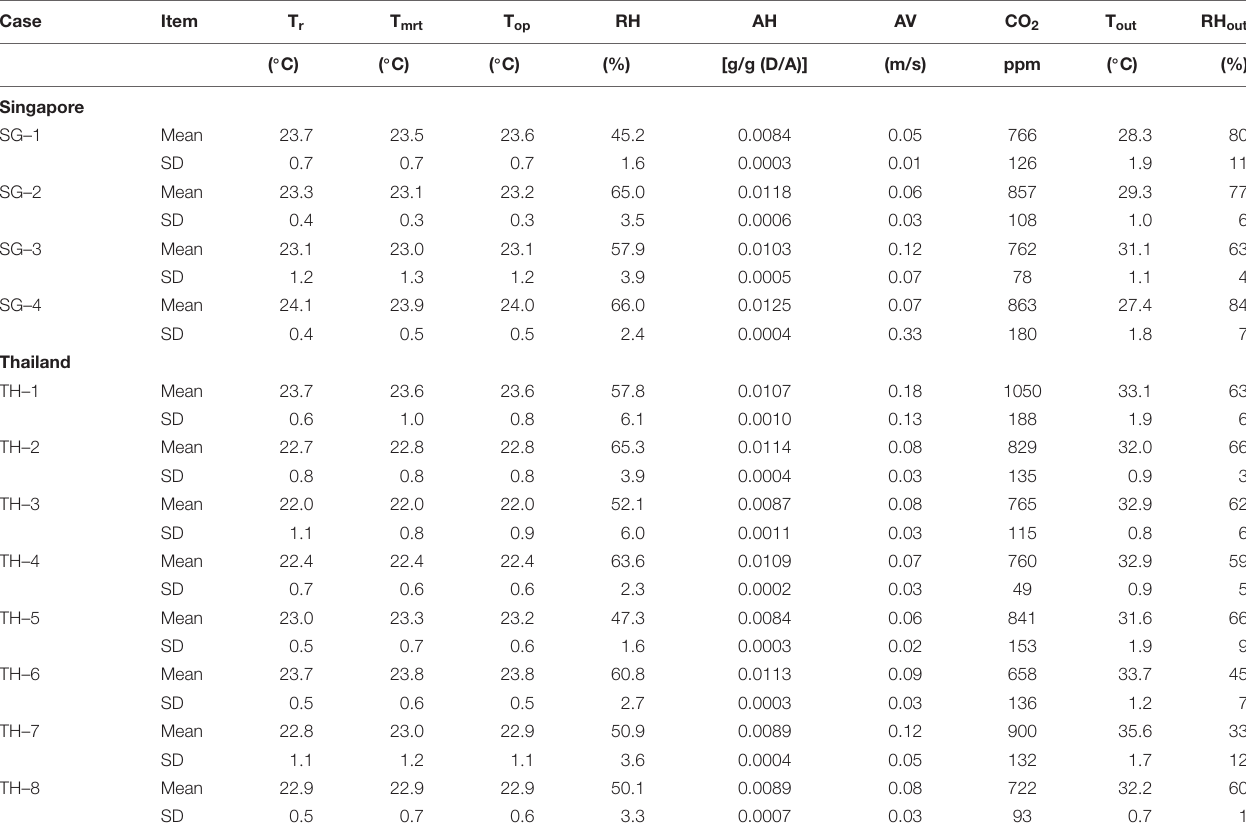
TABLE 3 | Average value of thermal variables in case studies.